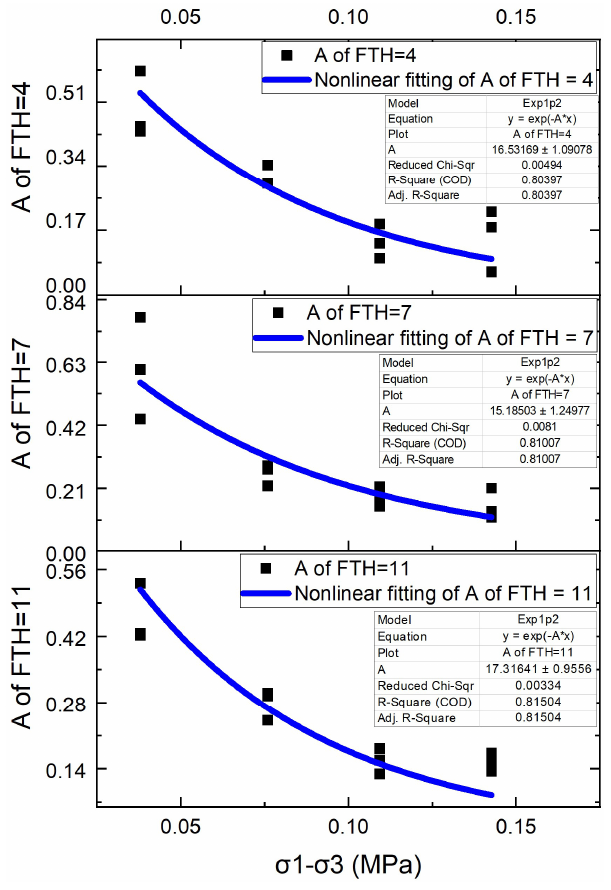
Figure 34. The correlations between A and low-level ADS ≤ 0.14268 MPa under different FTHs. When FTH = 4, a is fitted to be 16.53169 with Adj. R-Square being 0.80397. When FTH = 7, a is fitted to be 15.18503 with Adj. R-Square being 0.81007. When FTH = 11, a is fitted to be 17.31641 with Adj. R-Square being 0.81504.